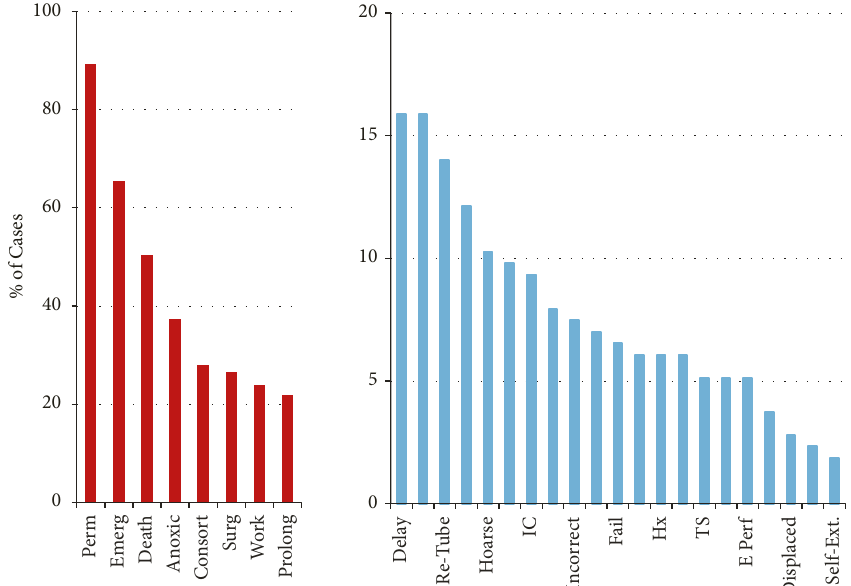
Figure 4: (a) Setting of alleged cause of malpractice, red (top) portion of bars represent cases resolved with payment (either out-of-court settlement or jury award), blue (bottom) portion of bars represent defendant verdicts. (b) Mean payment organized by setting. OR � operating room, ER � emergency room, ICU � intensive care unit, Flr � floor, L& D � labor and delivery, Pre � prehospital, PACU � anesthesia recovery unit, Cath � cardiac catheterization lab, Endo � endoscopy suite, Unk. � unclear